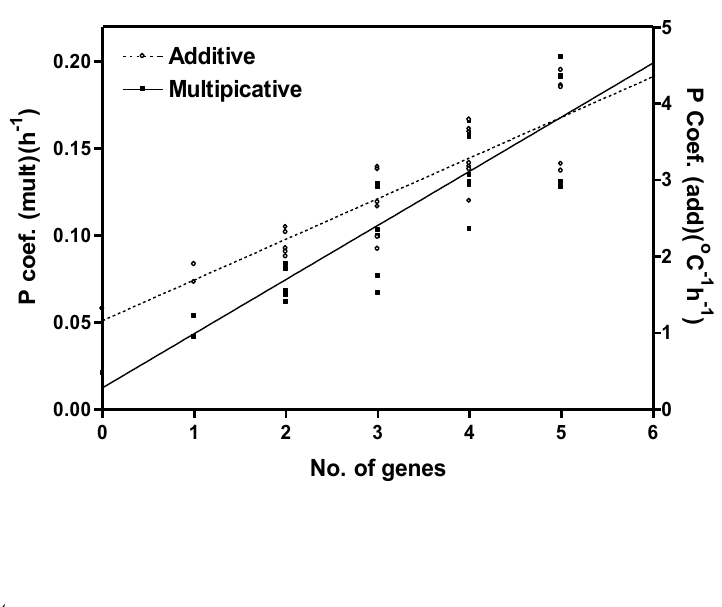
Figure 8. Photoperiod coefficients for soybean isolines (Y) for the multiplicative and additive models as related to the number of loci (X) in each isoline with dominant (late flowering) genes. For the multiplicative model, the equation is Y = 0.013 + 0.031X, R 2 = 0.79, SEE = 0.023 h −1 . For the additive model, the equation is Y = 1.15 + 0.531X, R 2 = 0.79, SEE = 0.389 °C h −1